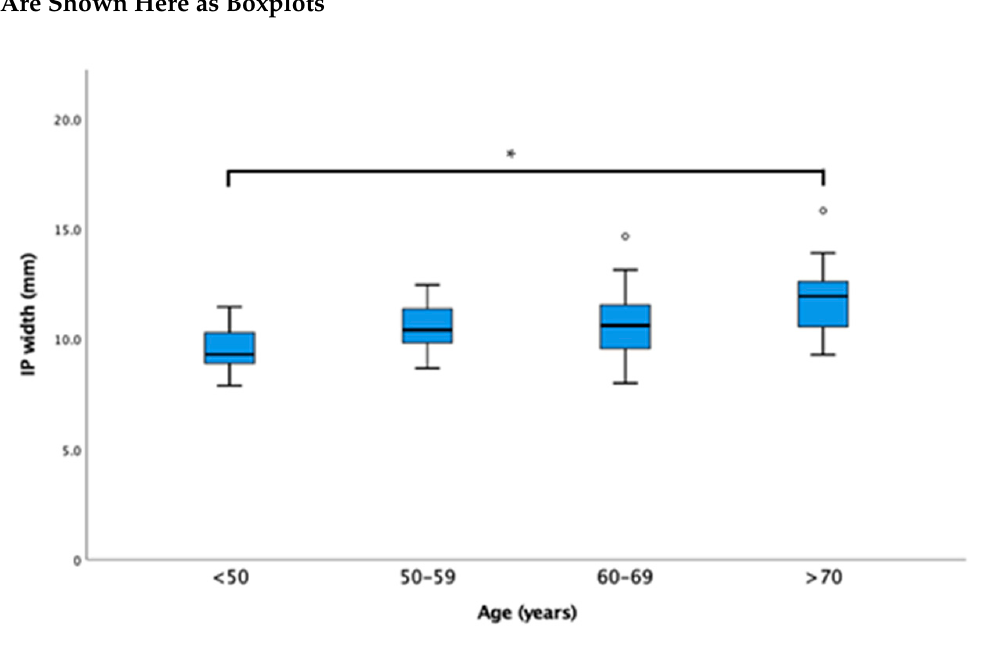
Figure A1. IP width with the age subgroups as box-plots. *: statistically significant be-tween groups; °: outliers.